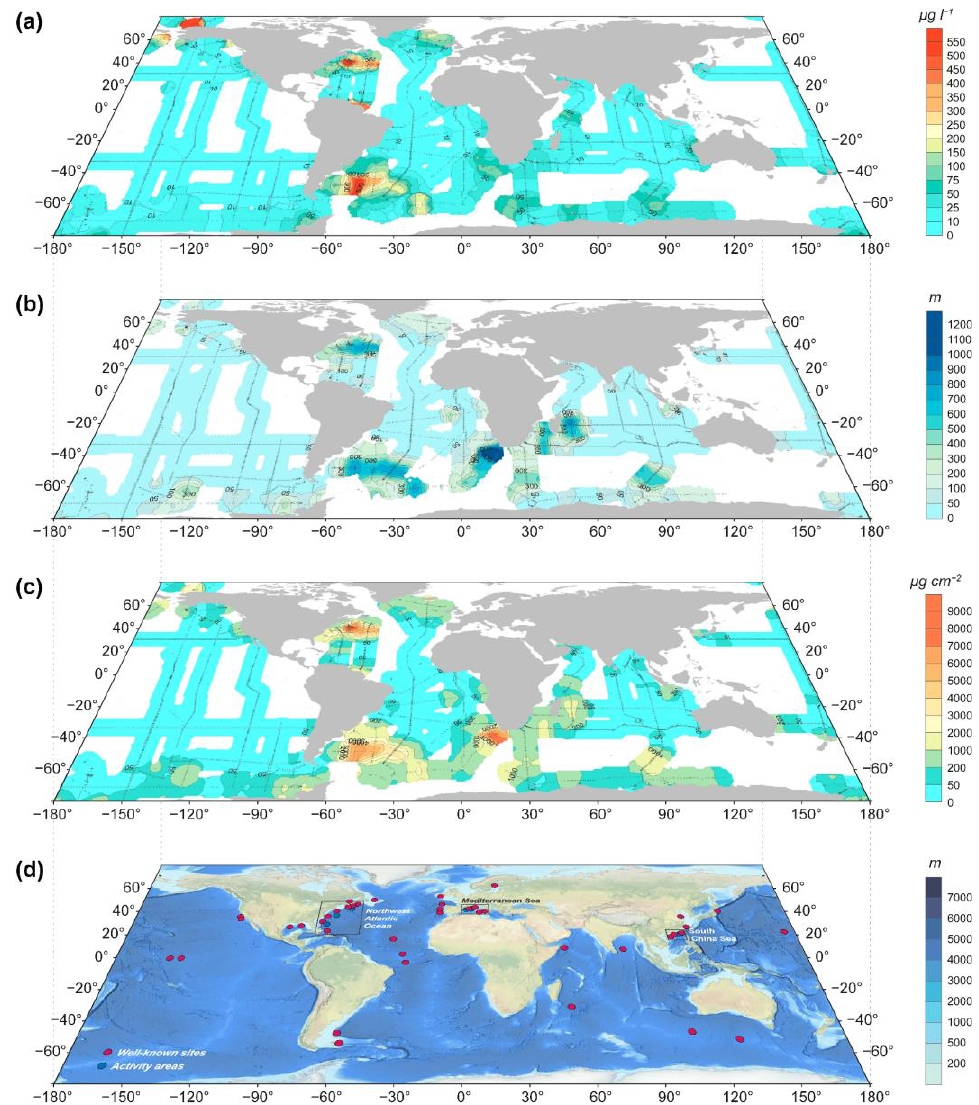
Figure 1. Global assessment and comparison of nepheloid layers based on vertical profiles of beam attenuation 𝑐 𝑝 data measurements from transmissometers. ( a ) Average SPM concentration in the bottom 10 m of each profile. ( b ) The strong nepheloid layer (>20 µg L −1 ) thickness; scale changes at 100 m thickness. ( c ) SPM load in the strong nepheloid layers (>20 µg L −1 ); scale changes between 0 and 1000 µg cm −2 . ( d ) The observed global nepheloid layers (1953 – 2019) and the map of global bathymetry. The well-known sites are those where nepheloid layers have been identified before and where their properties have been thoroughly described. The activity areas are places where nepheloid layer activity has been noted; however, the features are unknown. To show more precise information, scales are not linear. Panels ( a – c ) are adapted from Gardner, et al. [45] with permission from Elsevier, and panel ( d ) is adapted from Tian, et al. [46].